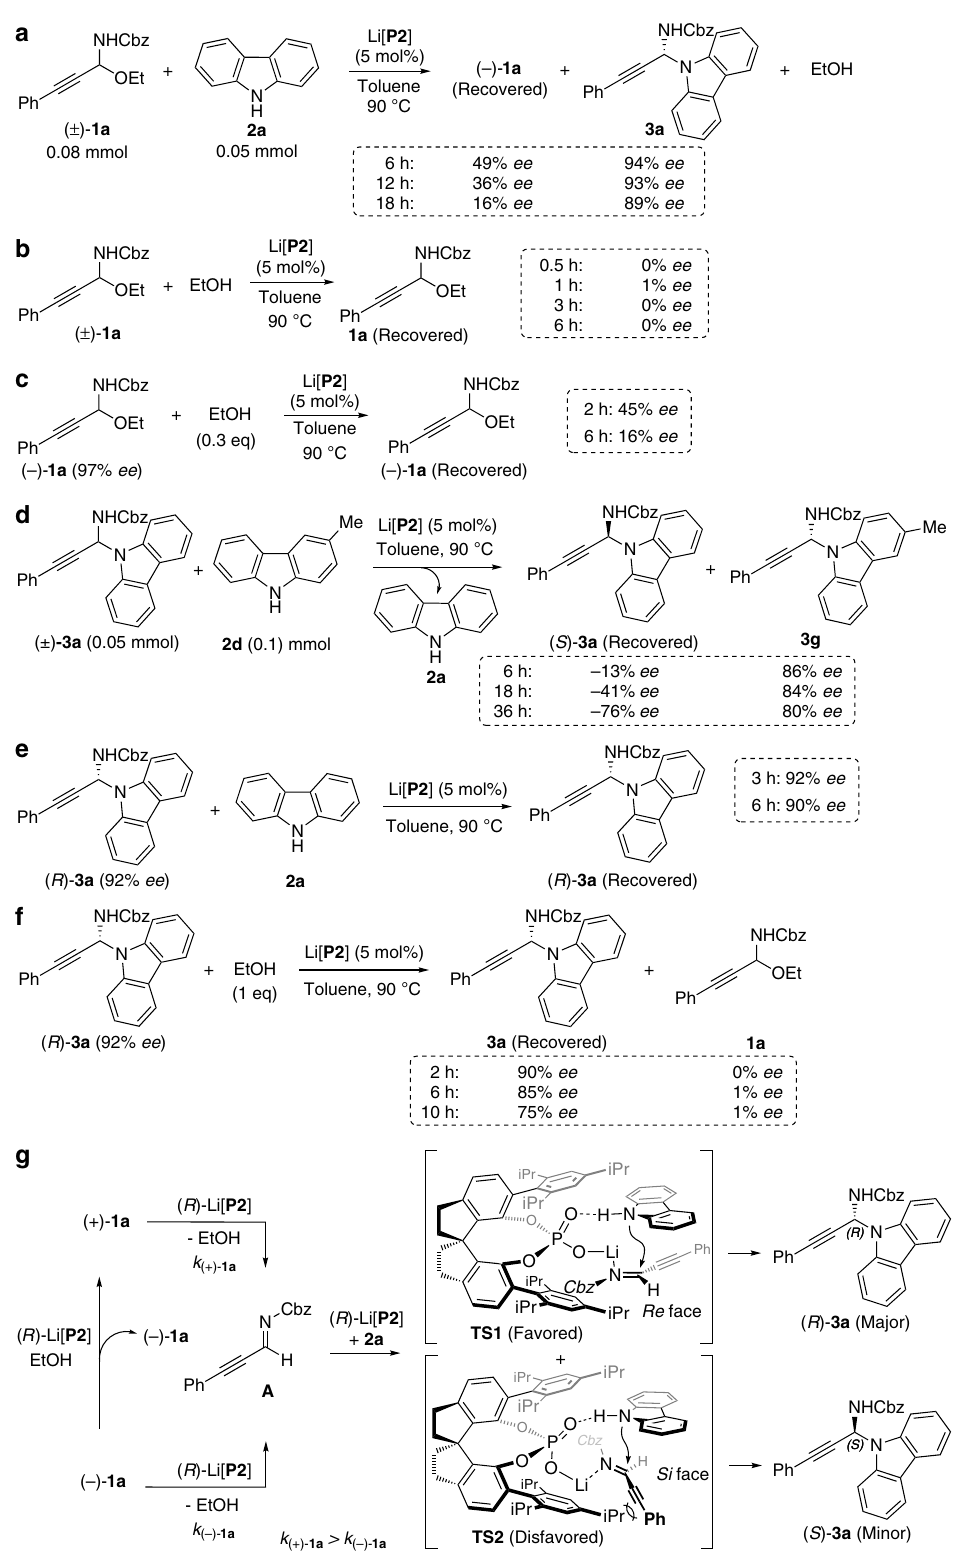
Fig. 3 Mechanistic investigations. a Enantioselectivity of the product 3a and the recovered substrate 1a over time. b The reaction of racemic 1a with EtOH under the chiral catalysis of Li[ P2 ]. c The reaction of chiral 1a with EtOH under the chiral catalysis of Li[ P2 ]. d Crossover experiment. e The reaction of chiral 3a with 2a under the chiral catalysis of Li[ P2 ]. f The reaction of chiral 3a with EtOH under the chiral catalysis of Li[ P2 ]. g Proposed reaction